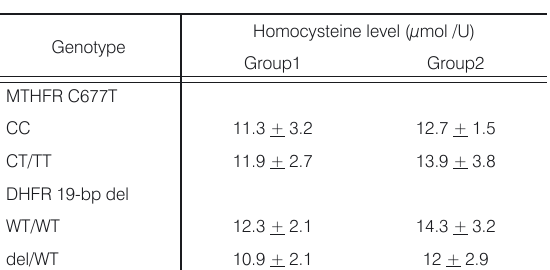
Figure 2. Changes of serum homocysteine levels in breast cancer patients.